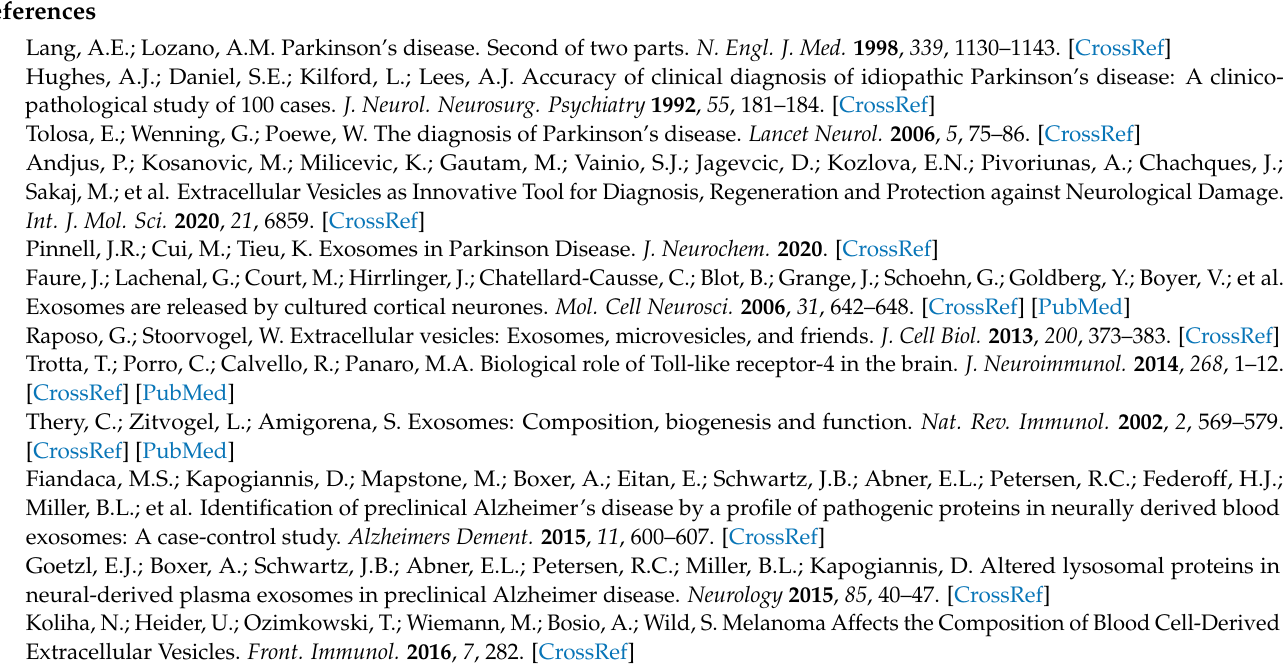
Table S4. EV surface antigens in plasma and CSF in pathological groups; Figure S1. EV surface